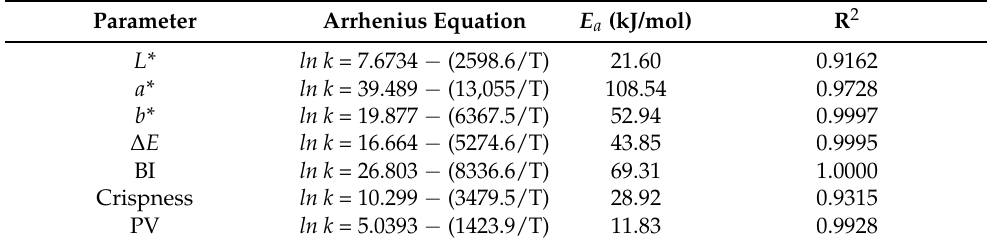
Table 2. The kinetic parameters of zero-order models for quality parameter in dried coconut